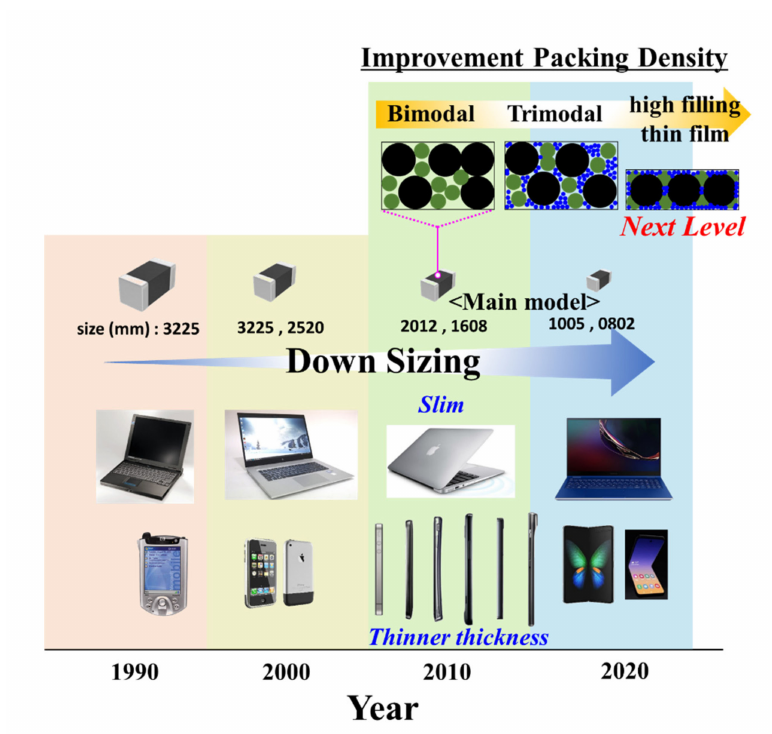
Figure 6. Roadmap of technology changes of power inductors required by the size change in various IT devices.